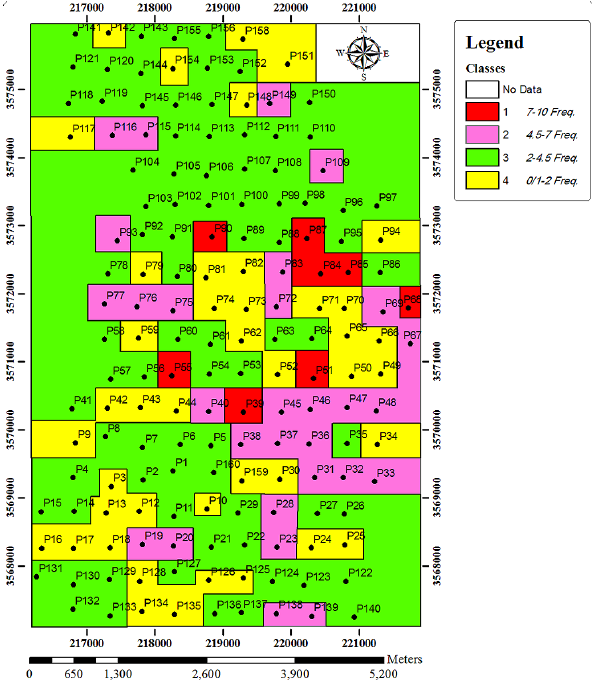
Figure 9. Ground type zonation of the region based on Nogoshi and Igarashi (1970, 1971).